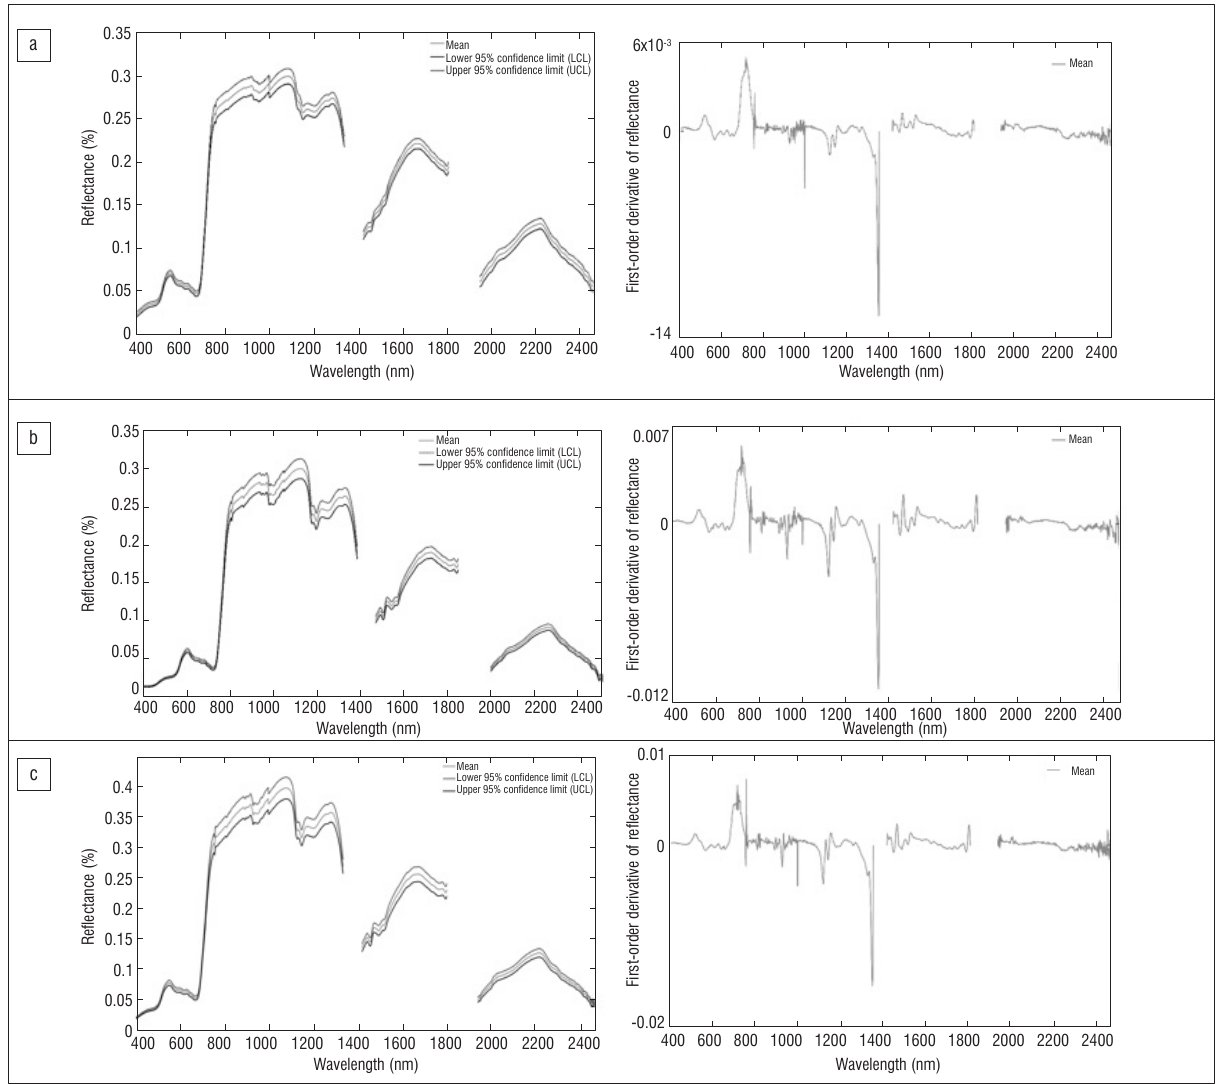
Figure 2: Mean and respective first-order derivative of canopy spectra of all grass subplots at the (a) beginning of, (b) mid- and (c) end of , root mean square error (RMSE) and the number of com- Table 1: R 2 cv po nents of training partial least square regression (PLSR) and interval PLSR (iPLSR) models prediction for the three sampling periods in summer and the pooled data Regression algorithm